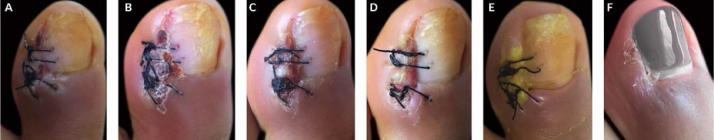
Post-operative healing process. (A) 3rd day, (B) 4th day, (C) 5th day, (D) 6th day, (E) 14th day, (F) 4th week.